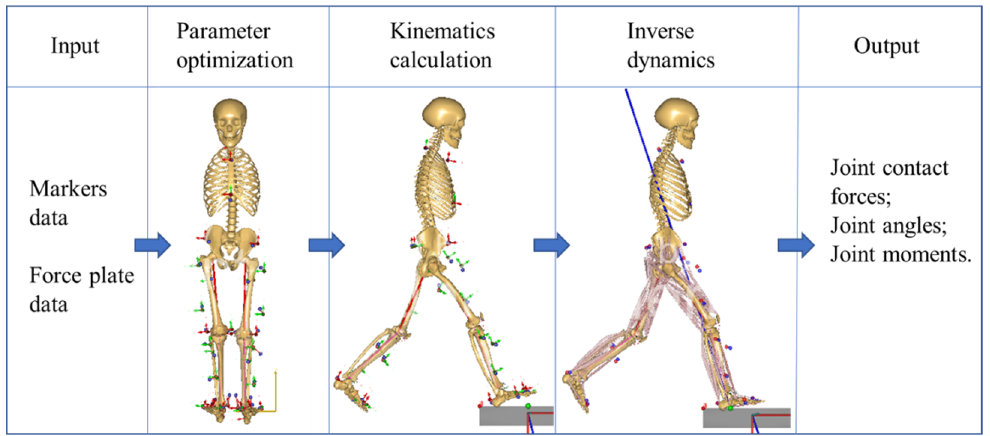
Figure 3. The workflow of the musculoskeletal multibody model.